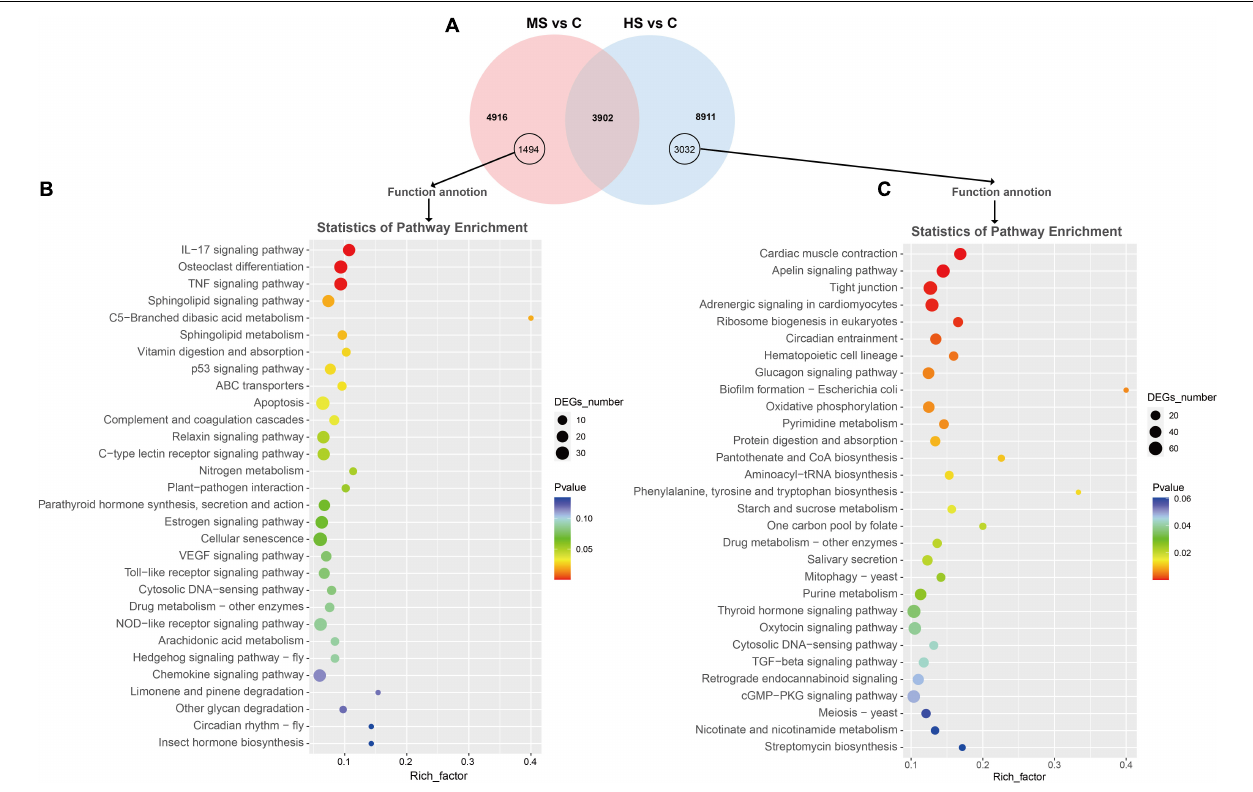
FIGURE 2 | Venn diagram and KEGG enrichment analysis of the non-shared DEGs in MS vs. C and HS vs. C groups. (A) Venn diagram showed 1,494 and 3,032 non-shared annotated DEGs in MS vs. C and HS vs. C groups, respectively. (B,C) Scatter diagram of KEGG enrichment analysis. X -axis (enrichment factor) indicates the enrichment level of DEGs in each pathway, while Y -axis represents the reliability of enrichment analysis of each pathway.